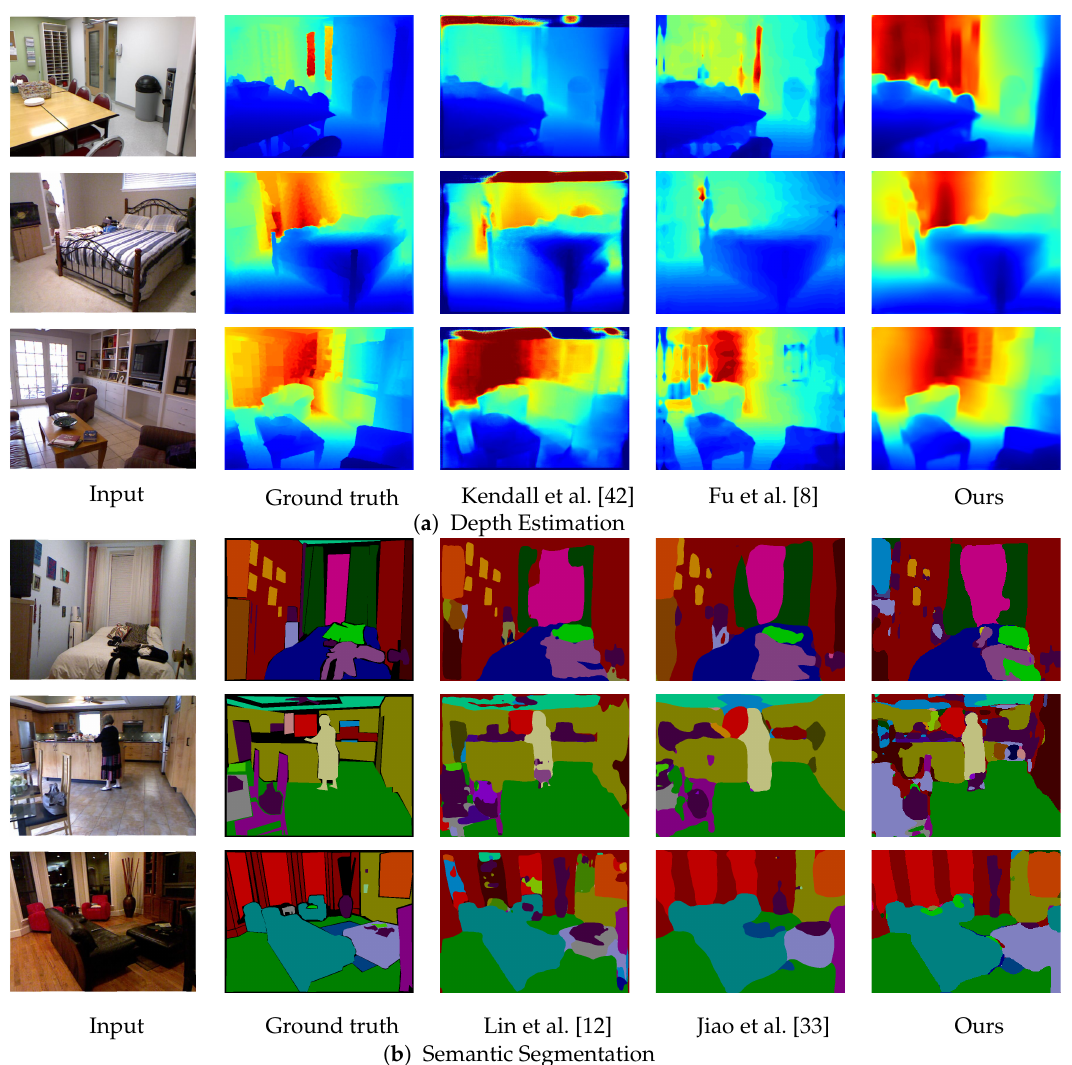
Figure 4. Qualitative comparison with state-of-the-art single task